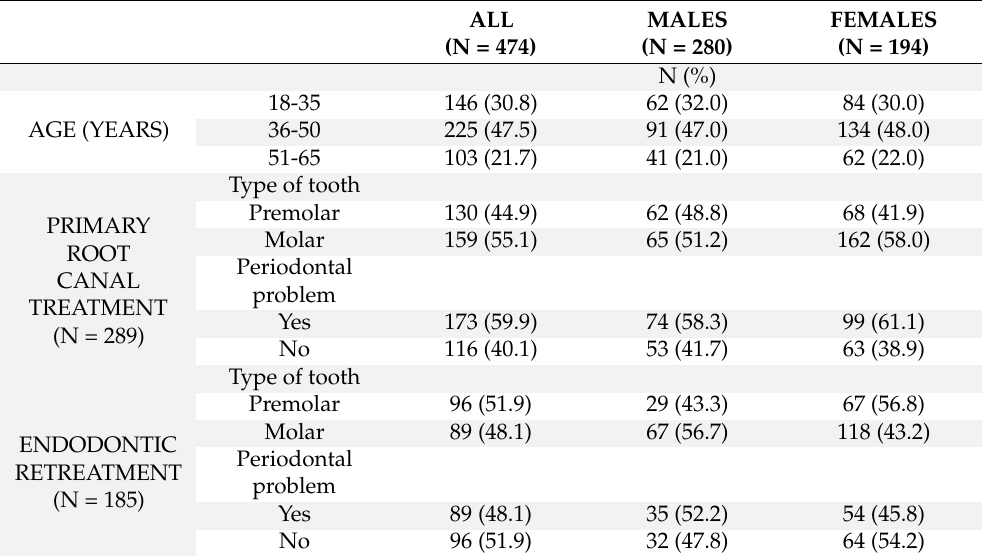
Table 1. Characteristics of the study participants (n =